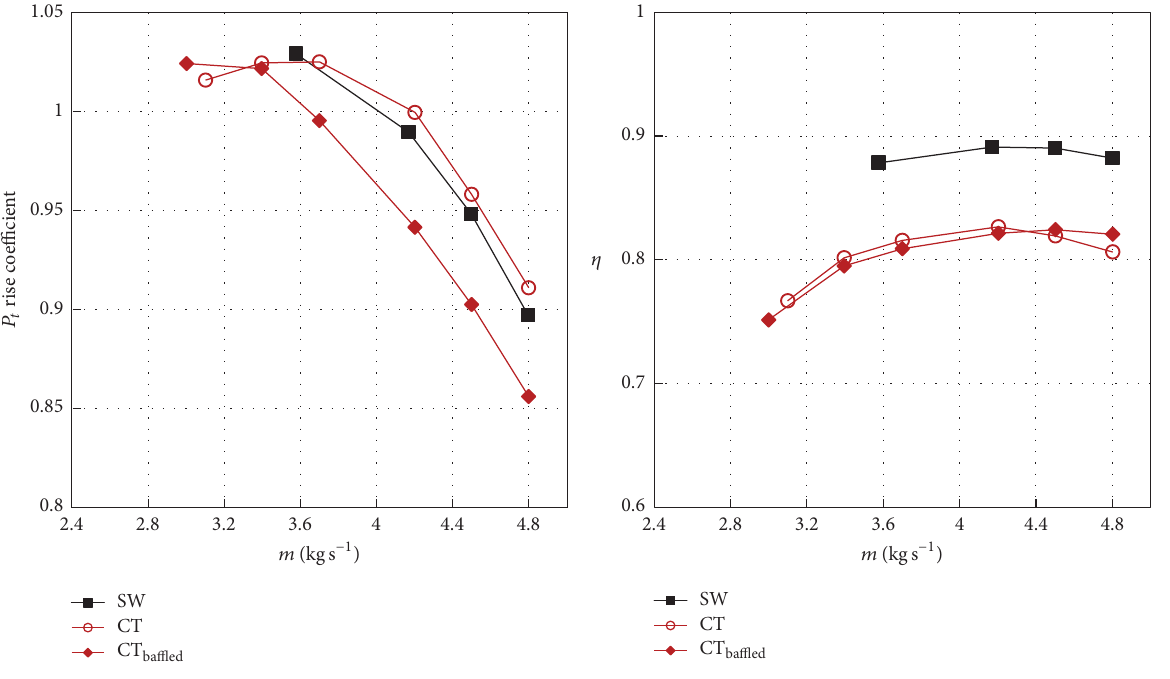
Figure 4: Overall performance of the baseline casing treatments.